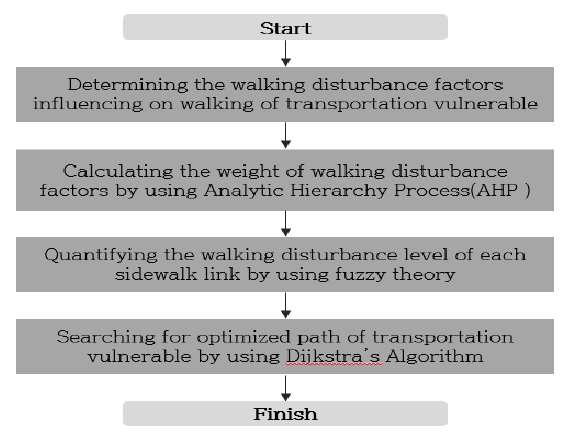
Figure 1. Flowchart of process of searching for optimized